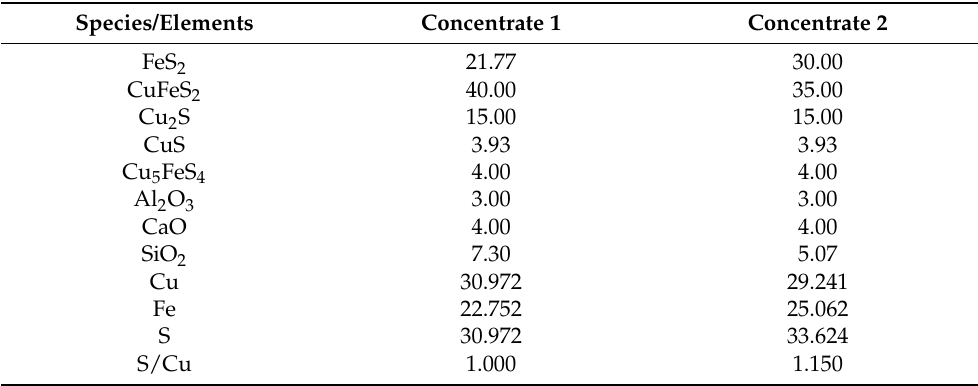
Table 1. Chemical and mineralogical characterization of two concentrates used for calculation presented in Figure